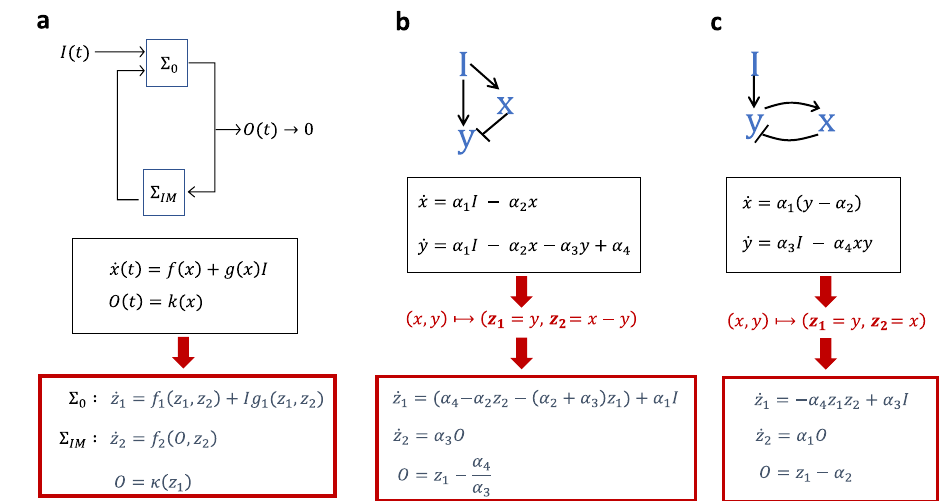
Fig. 1 | The internal model principle (IMP) and its application to RPA-capable beabletorecastanRPA-capablesystemintointegralfeedbackform,evenifthereis CRNs. The class of constant disturbances ( I ( t )=const) is generally the disturbance no feedback present in the network. As shown, a lineartransformation is suf fi cient to identify an output-driven internal model for this particularly simple incoherent class of most fundamentalinterest to the study of biologicalsystems. a Inorderto feedforward motif (Balancer module); y = α 4 = α 3 (setpoint) at steady-state. c A exhibitRPA(i.e.adapttoconstantdisturbances),thedynamicalsystem Σ shouldbe model that employs feedback is frequently simpler to recast in ‘ integral feedback ’ decomposable, via a coordinate transformation if needed, into an ‘ output-driven P form, with an output-driven internal model; here y= α 2 (setpoint) at steady-state. internal model ’ , P IM (generating all the constant signals corresponding to solu- tions of _ z 2 =0), and the remainder of the system, Notethatthereactionratesselectedforillustrativepurposesin( b )or( c )cannotbe 0 . The variable z 2 thereby computes the integral of the output error. b A suitable coordinate change should induced, under the law of mass action, by any CRN 20